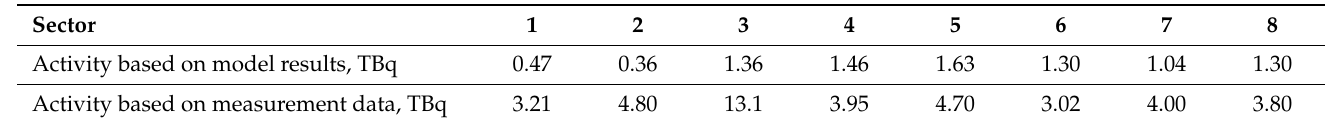
Table 4. Calculated and measured total activities of 90 Sr in bottom sediments in eight sectors of the CP in 2013.